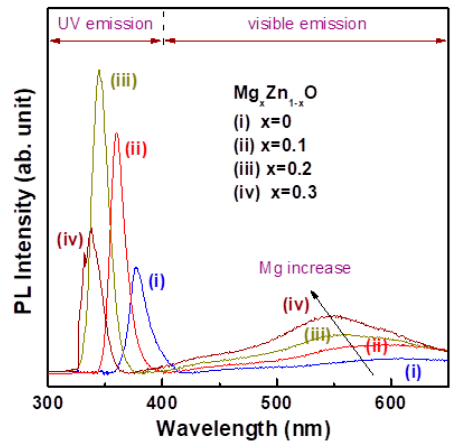
Figure 6. Room temperature photoluminescence (PL) spectra of nanocrystalline Mg x Zn 1 − x O thin films.